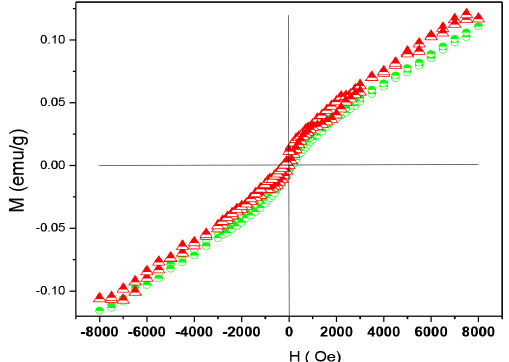
Fig. 4. SEM image of a sample (nano composite containing low Cu content)after